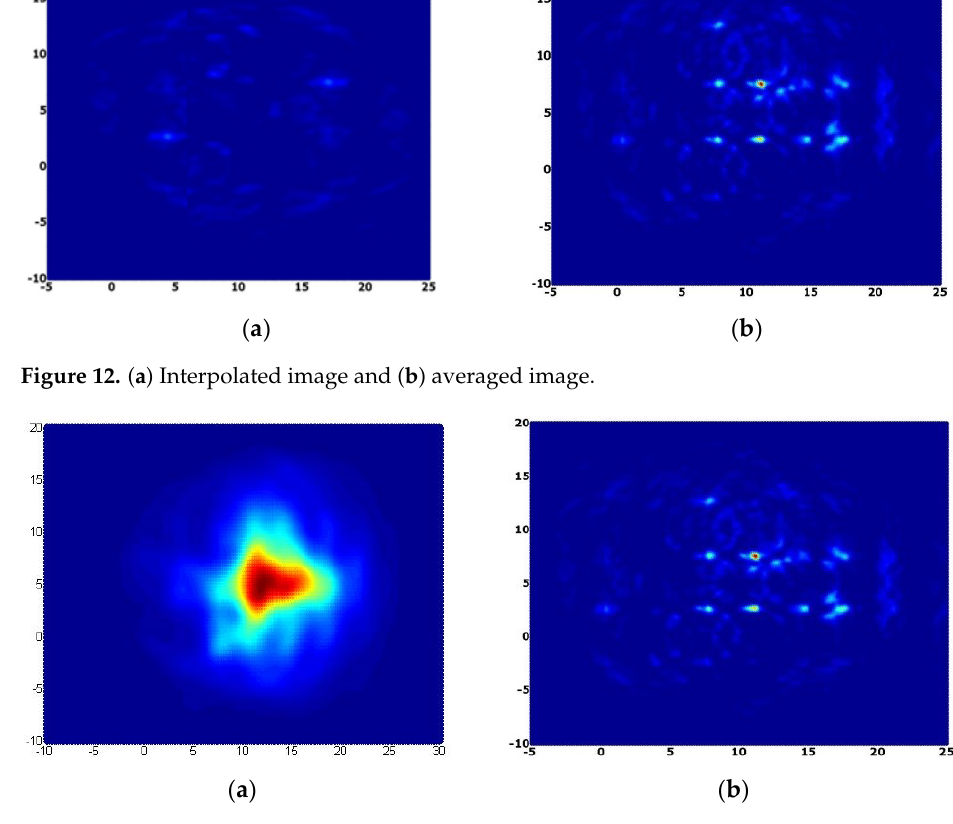
Figure 13. Final image; ( a ) with tumor, ( b ) without tumor.